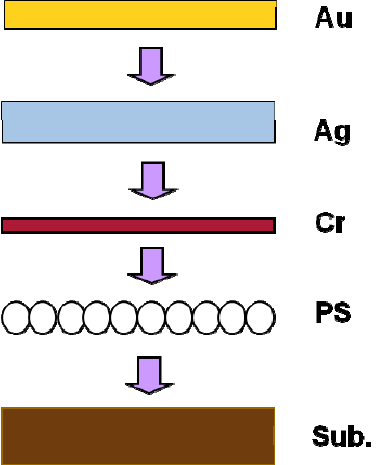
Figure 4. Schematic illustration for the fabrication process of the hybrid Au-Ag nanoparticle